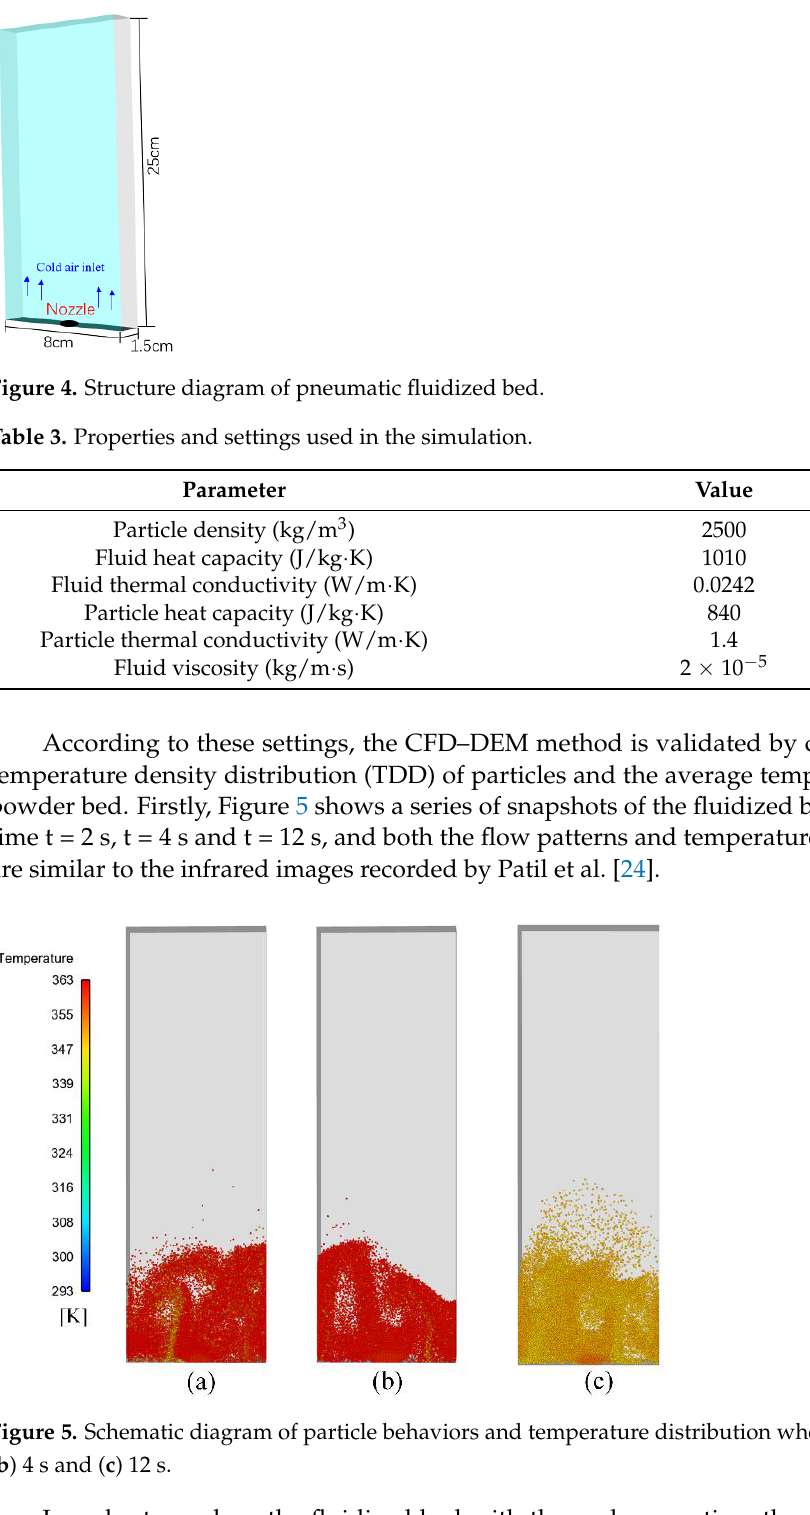
( b ) 4 s and ( c ) 12 s.